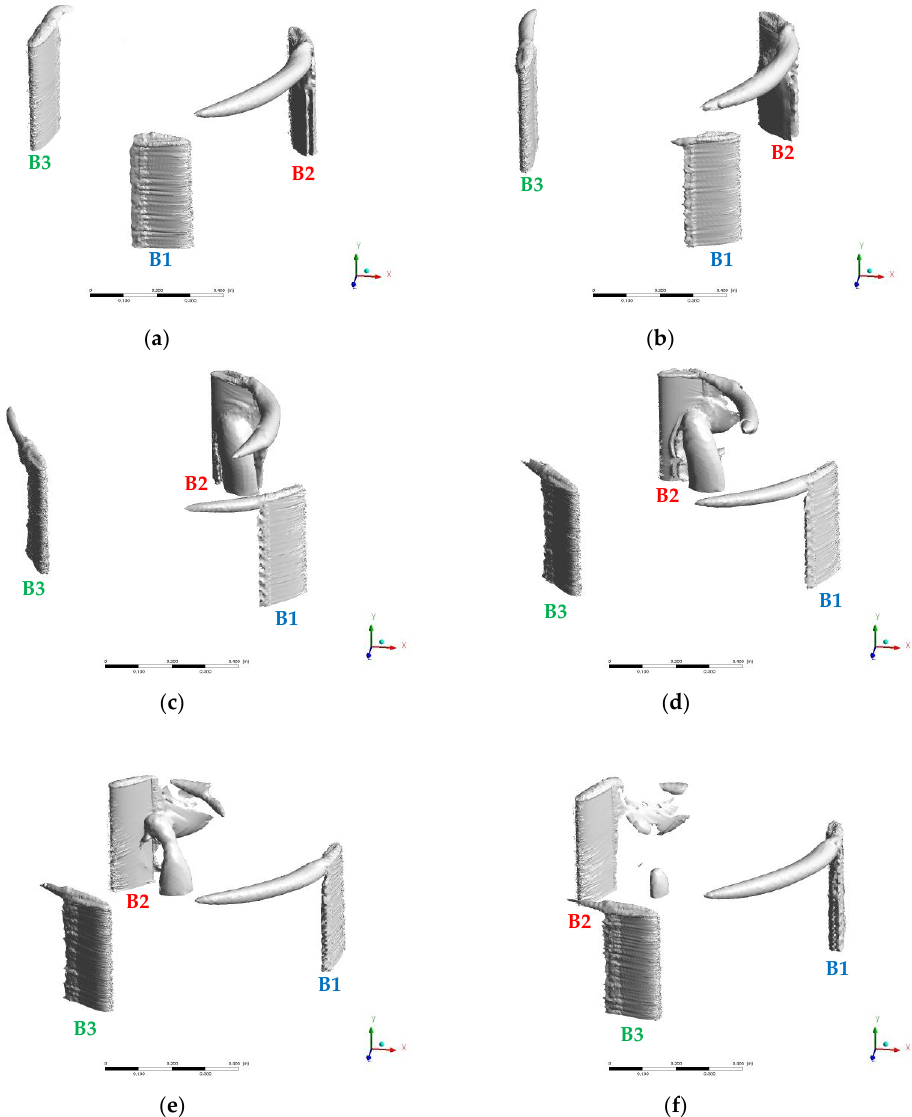
Figure 9. 3D visualization of the evolution of the vorticity iso-surface of 60 Hz for Ω = 60 rpm. Azimuth angle change at each view from ( a – f ) corresponds to 20 o , approximately.